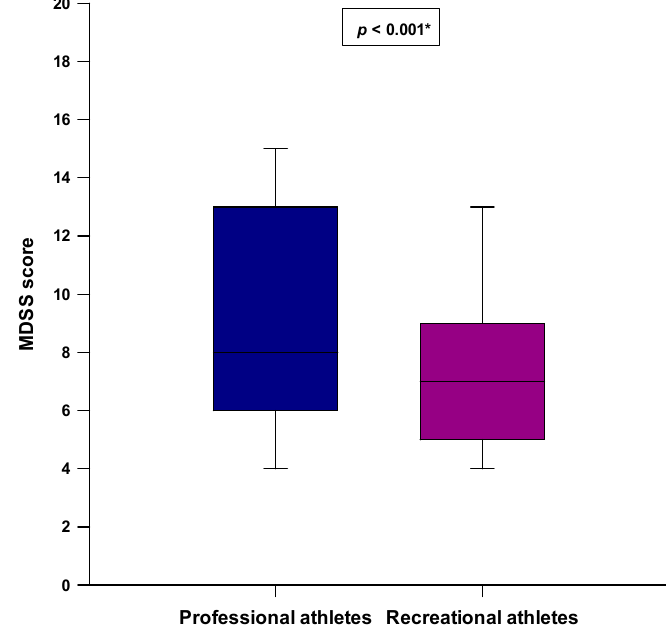
Figure 1. Difference in the total MDSS score between the professional athletes ( N = 150) and recreational athletes ( N = 150). * Mann–Whitney U test.